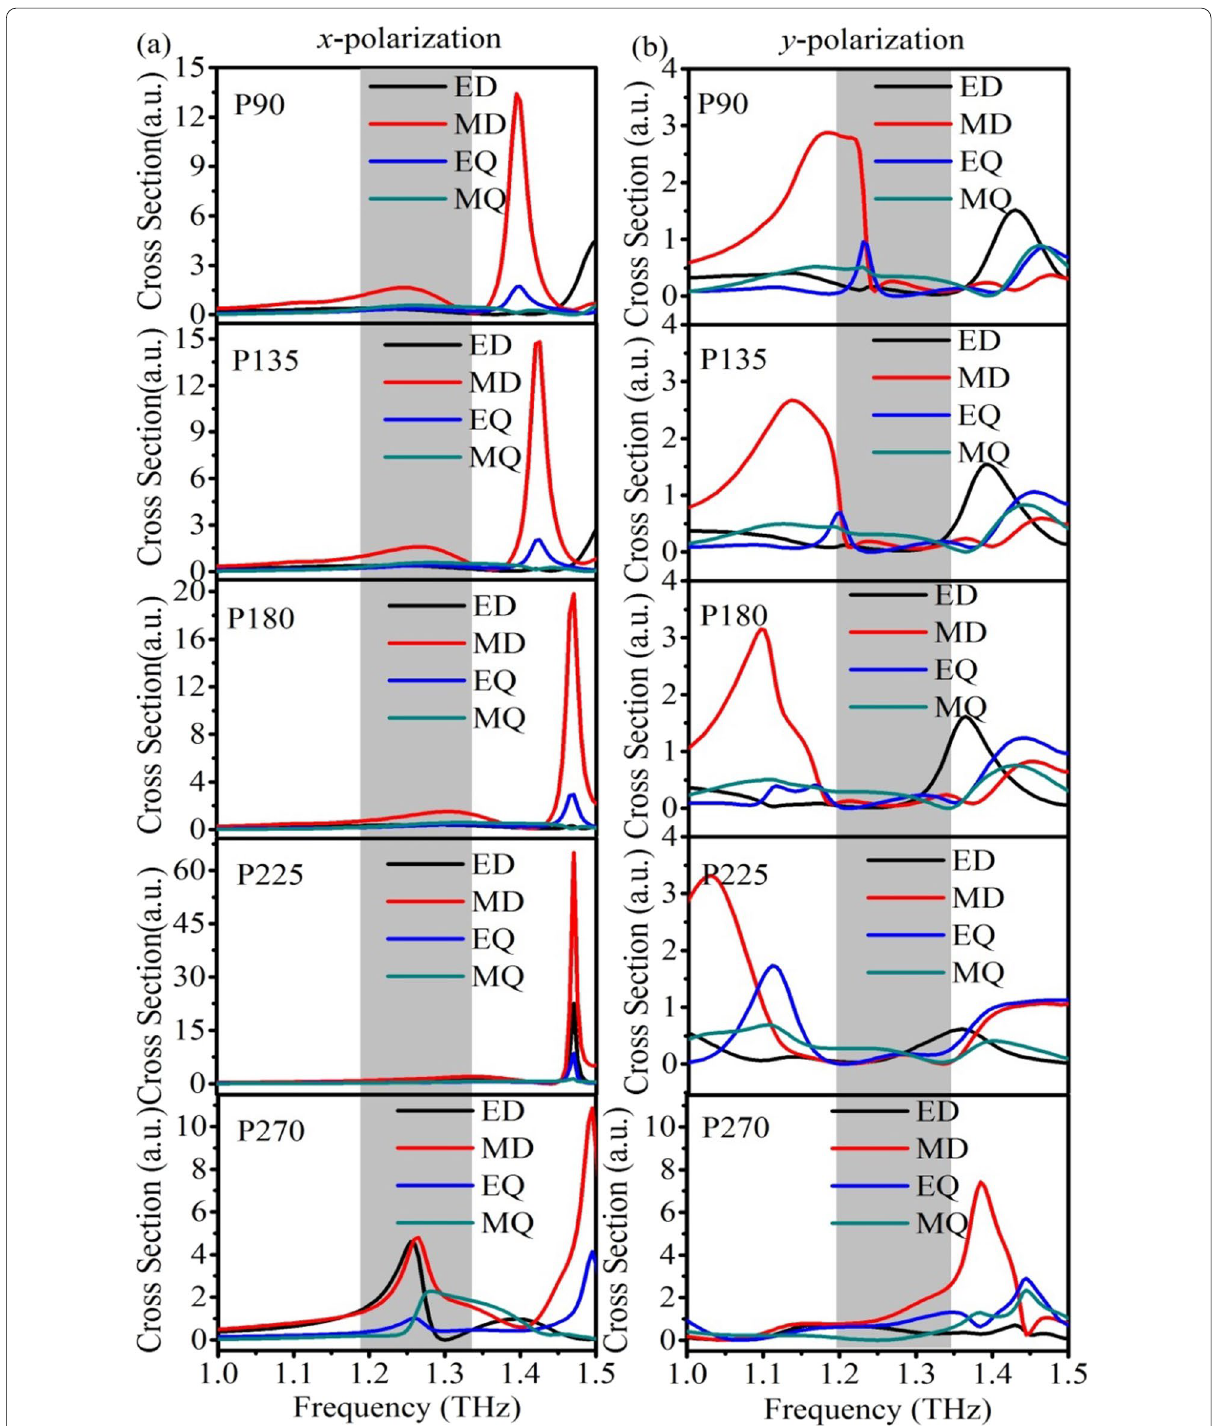
Fig. 4 Multipole decomposition of the SCSs for the ED, MD, EQ and MQ resonances under a x - and b y -polarized